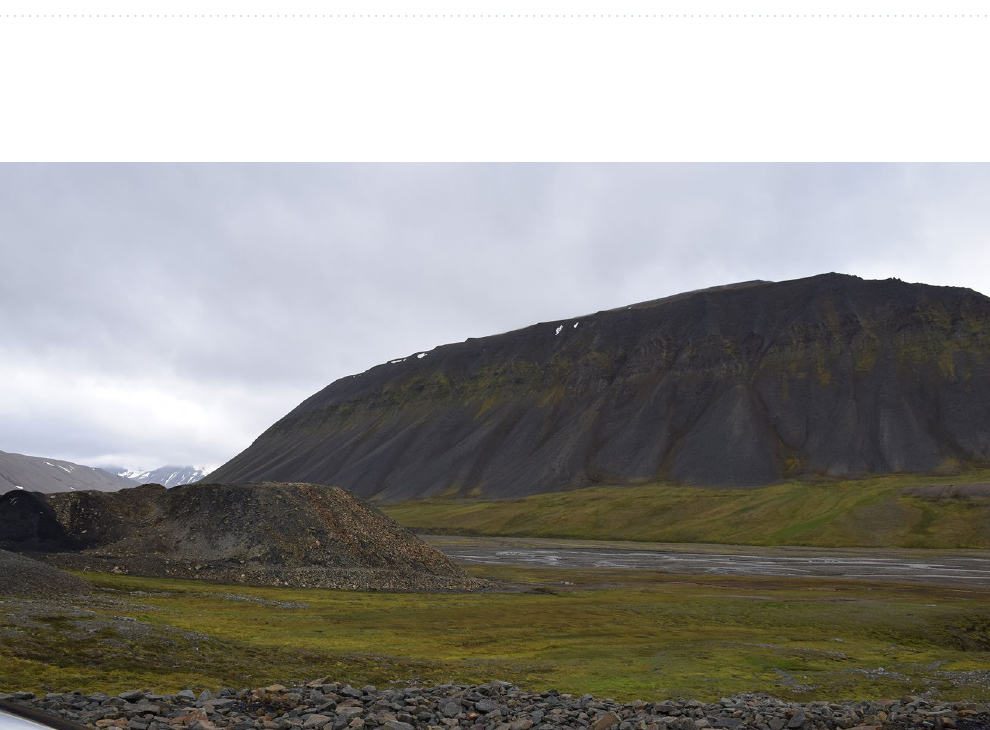
Figure 4. The general view of the Colesdalen study site. Vegetation and microforms in Colesdalen are similar to those of the Bjørndalen and Bolterdalen. In the front and at the back of the image non-vegetated mineral disturbance surfaces can be